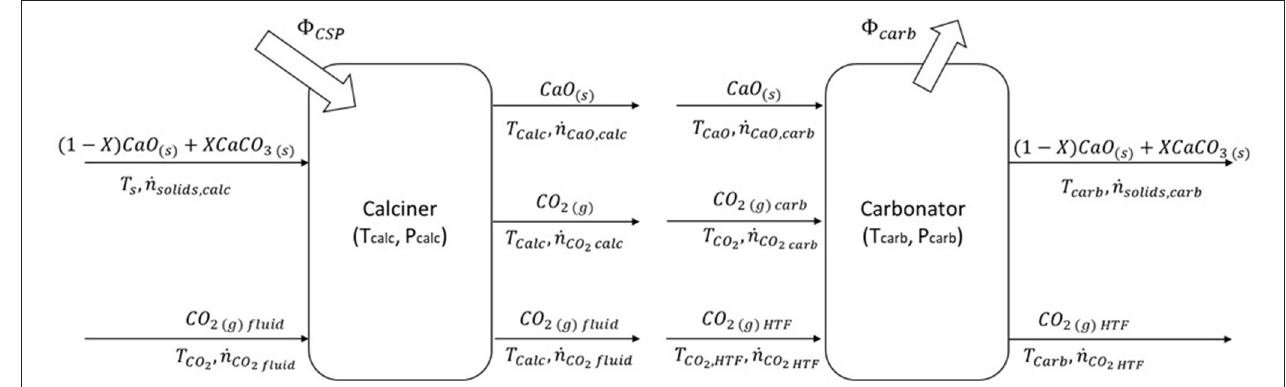
FIGURE 3 | Molar and energy balance of the calcium looping process. On the left side, in the calciner, solar energy is collected and stored in chemical compounds; on the other side, CaO and CO 2 react into the carbonator reactor. The heat of the exothermic reaction is transported by the CO 2 used as HTF to the power block. Adapted with permission from Cannone et al. (2020). Copyright 2021 American Chemical Society.